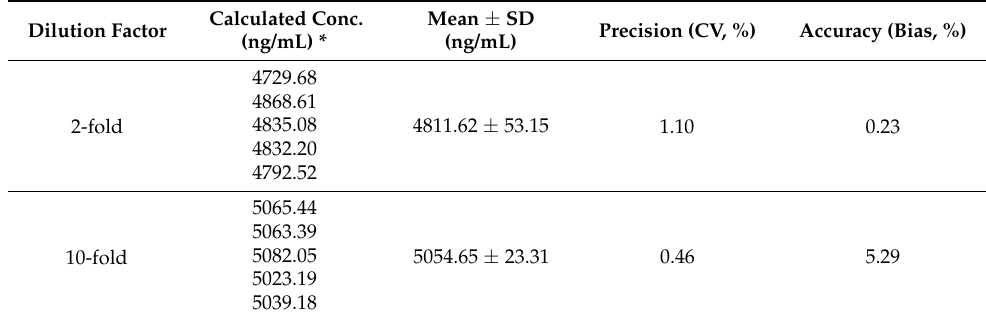
Table 4. Dilution integrity results of etoricoxib ( n = 5). Calculated Conc. Dilution Factor (ng/mL)